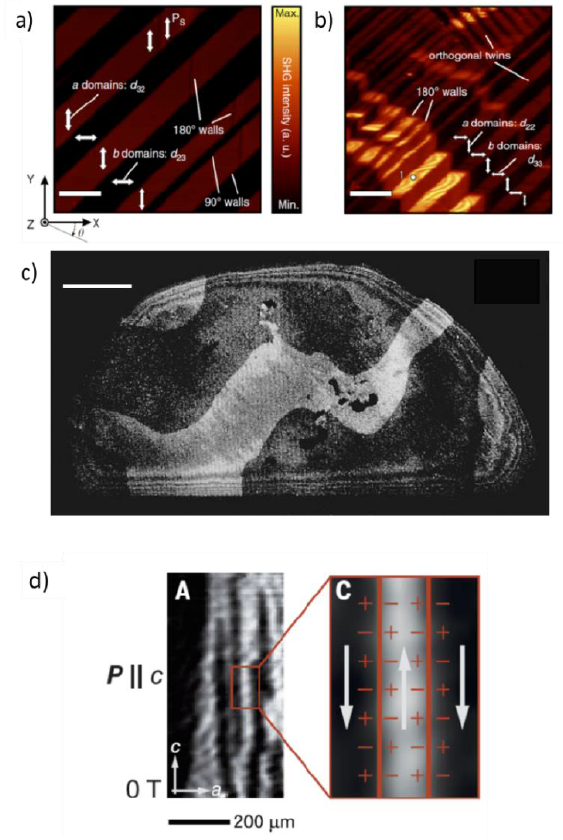
Figure 6. Imaging ferroic domains in bulk using SHG. ( a ) Ferroelectric domain structure in BaTiO 3 (BTO). The scale bar is 8 µ m. ( b ) Observation of orthorhombic twinning in a BTO crystal. The scale bar is 12 µ m. Reprinted by permission from [83], Copyright Macmillan Publishers Ltd.: Nature Communications, 2014. ( c ) Antiferromagnetic domains in Cr 2 O 3 , reprinted with permission from [84] Copyright AIP Publishing, 1995. Scale bar is 1 mm. ( d ) Multiferroic domains in TbMnO 3 , Reprinted with permission from [86], Copyright AAAS,